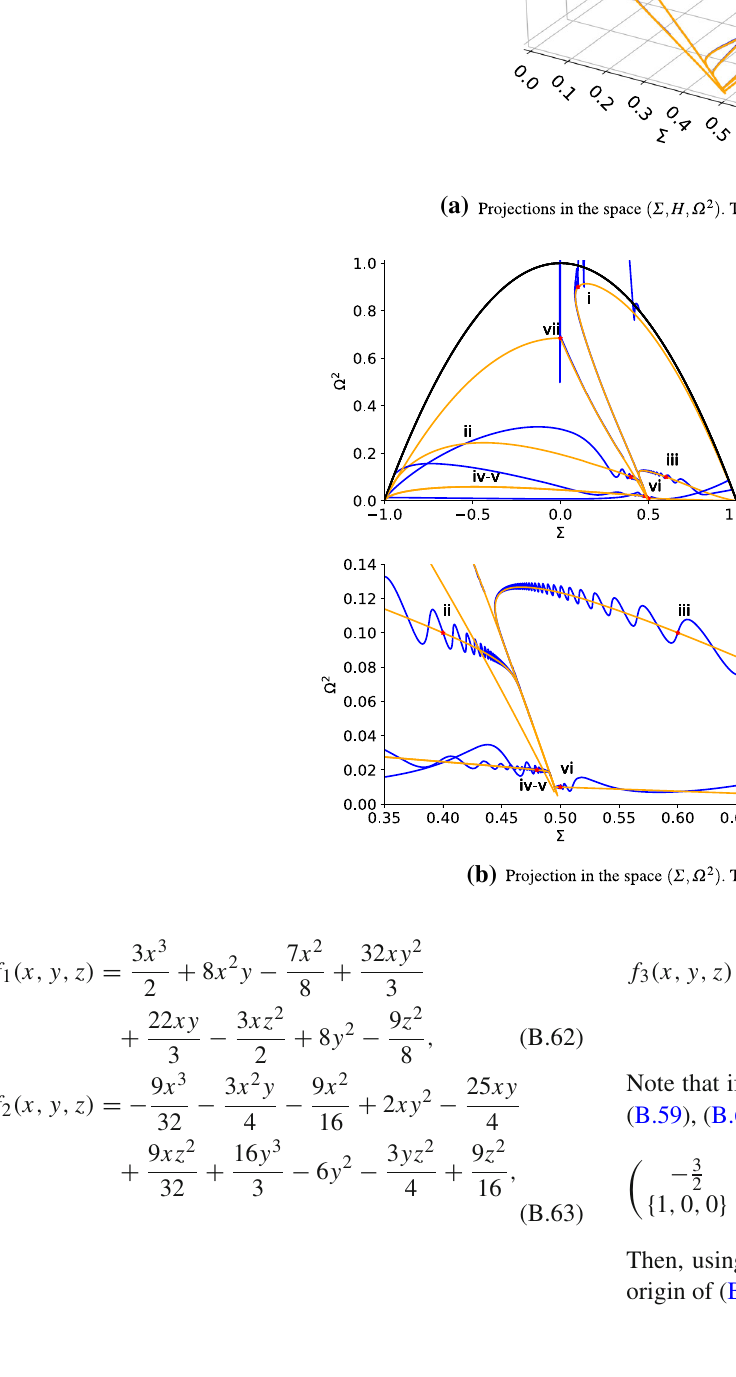
Fig. 15 Some solutions of the full system (46) (blue) and time-averaged system (78) (orange) for the LRS Bianchi III metric when γ = 1, in the projection Ω k = 0. We have used for both systems initial data sets presented in the Table